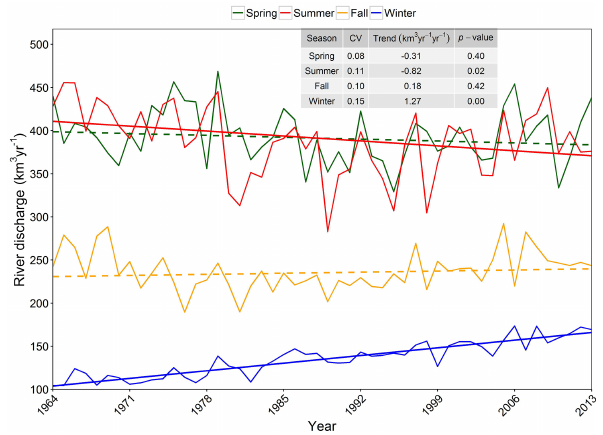
Figure 5. Time series of total seasonal discharge for 42 rivers drain- ing northern Canada, 1964–2013. Thick solid (dashed) lines denote statistically significant (insignificant) trends.